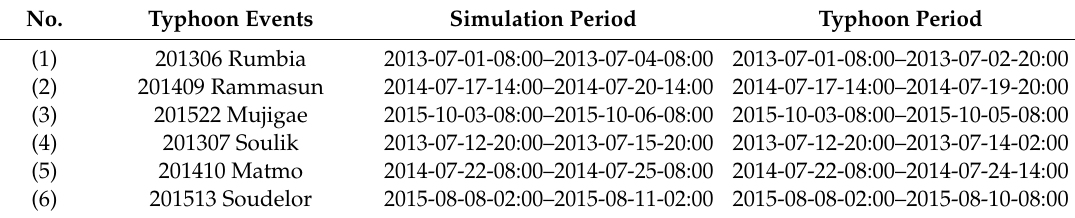
Figure 1. Two-grid nested study domain, with six observed typhoon tracks included in the inner layer domains of d02A and d02B. The d02A and d02B includes 3-days typhoon tracks of events (1) − (3) and events (4) − (6) respectively. Table 1. Selected typhoon events from 2013 to